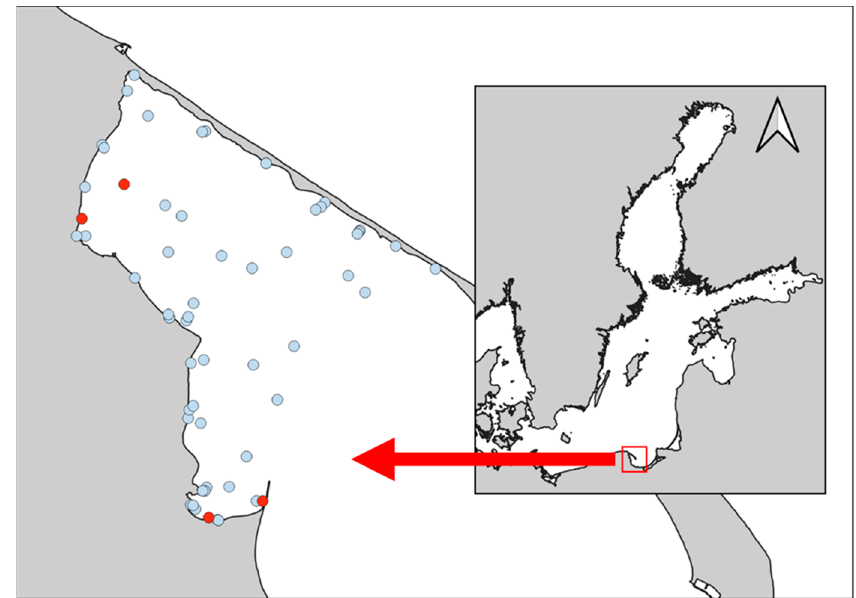
Figure 1. Location of sampling sites (red-coloured spots indicate Coccotylus brodiei and Furcellaria lumbricalis collection sites). The inset shows the location of Puck Bay.